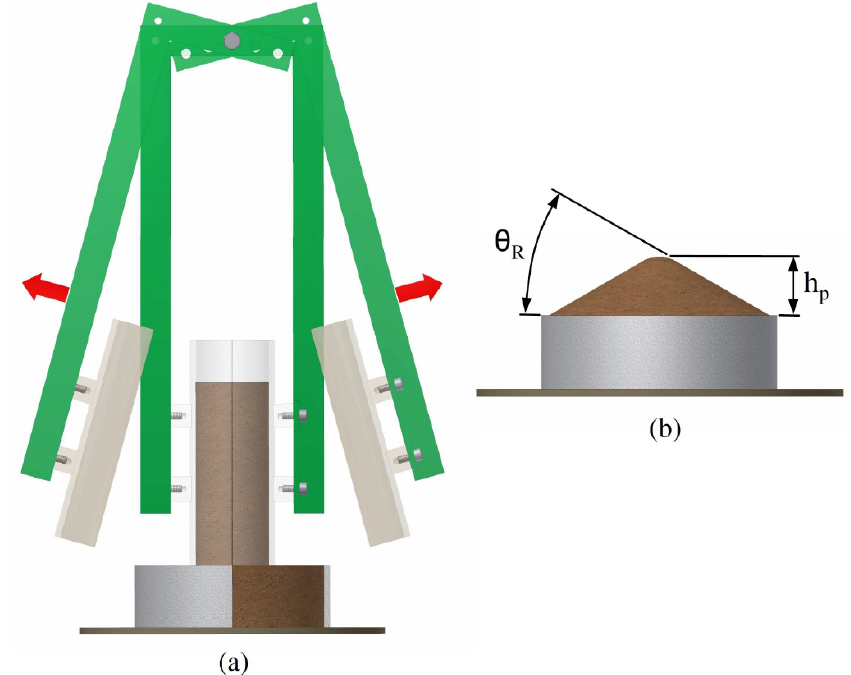
Figure 17. Angle of repose slump tester introduced by [64] showing ( a ) the initial configuration and opening mechanism, and ( b ) the formed heap. Reproduced with permission from A. Grima.